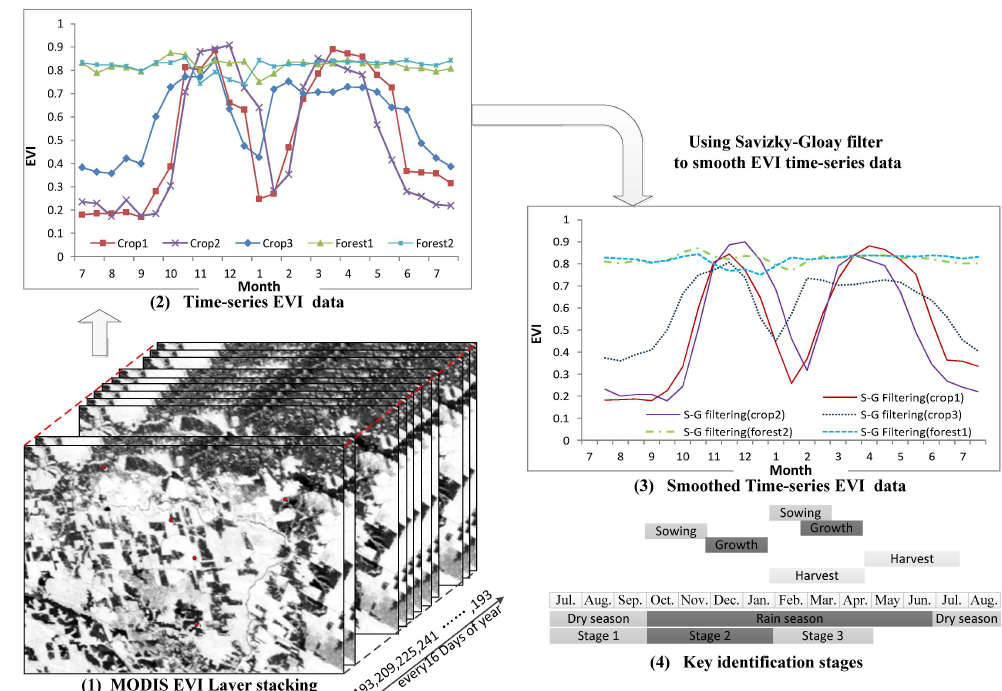
Figure 3. Determination of key identification stages based on crop phenology